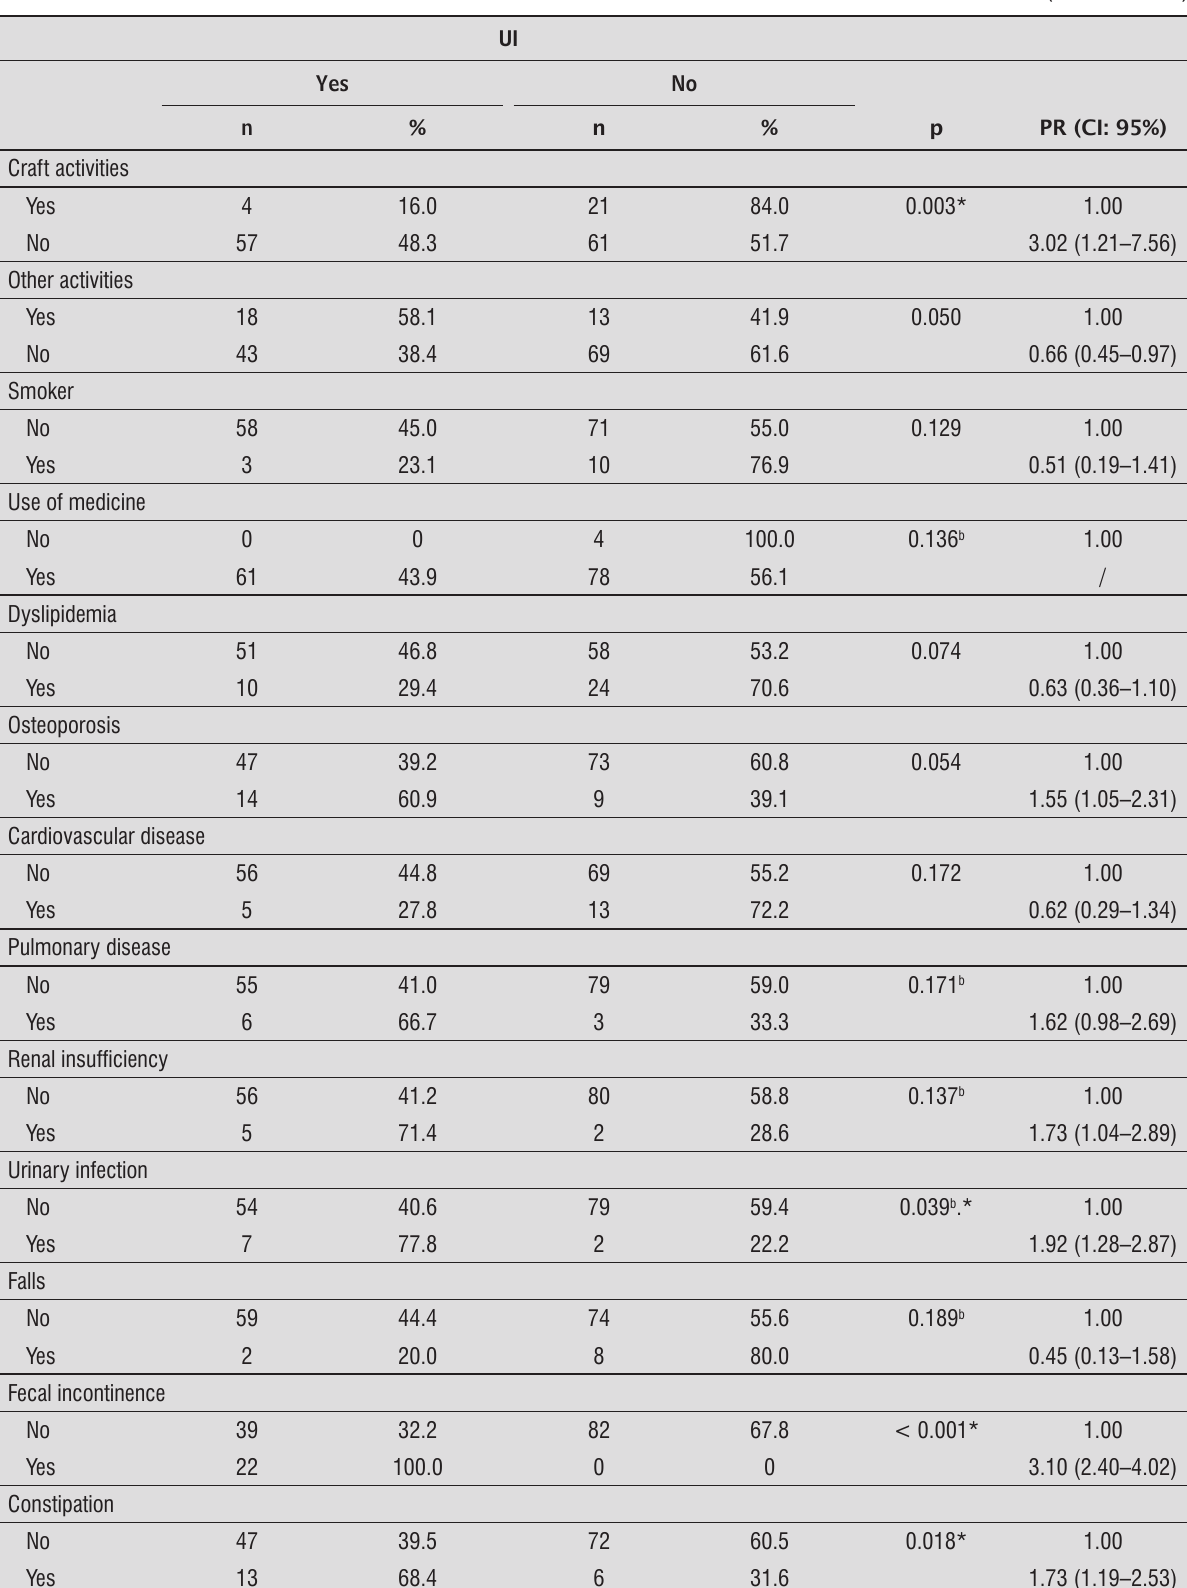
Table 3 - Association between UI and sex and those independent variables with p value under 0.20 – Natal (RN), 2014 UI